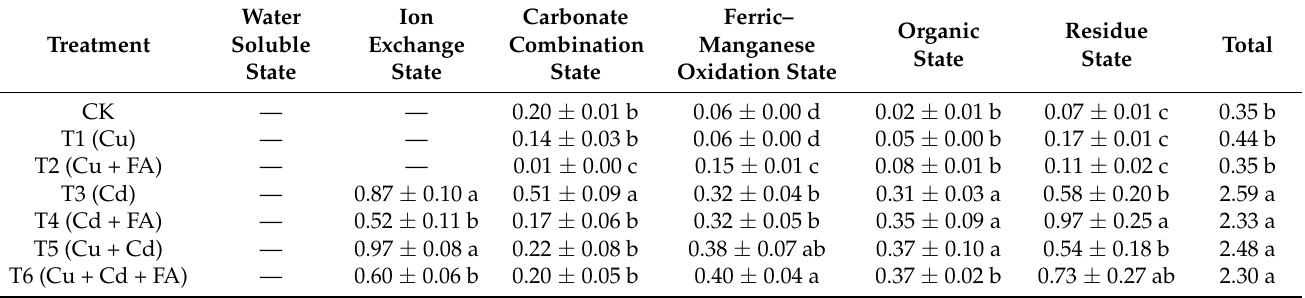
Table 5. The contents of different Cd forms in the topsoil under different Cu, Cd stress (mg · kg − 1 ).